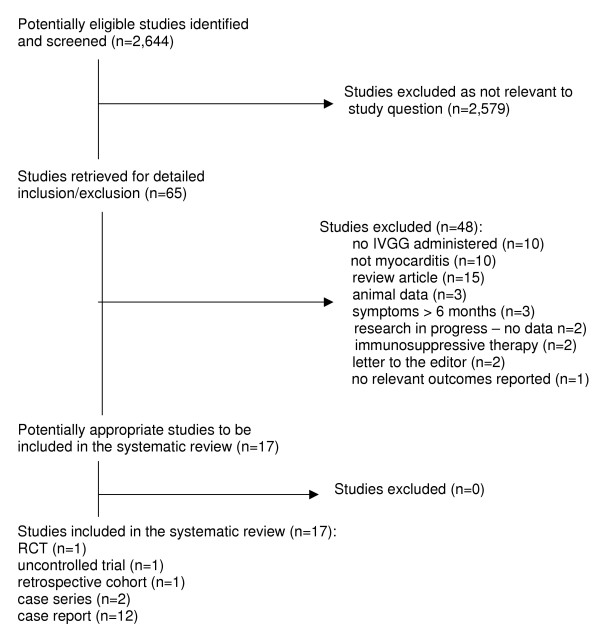
Flow diagram of studies considered for inclusion in the review